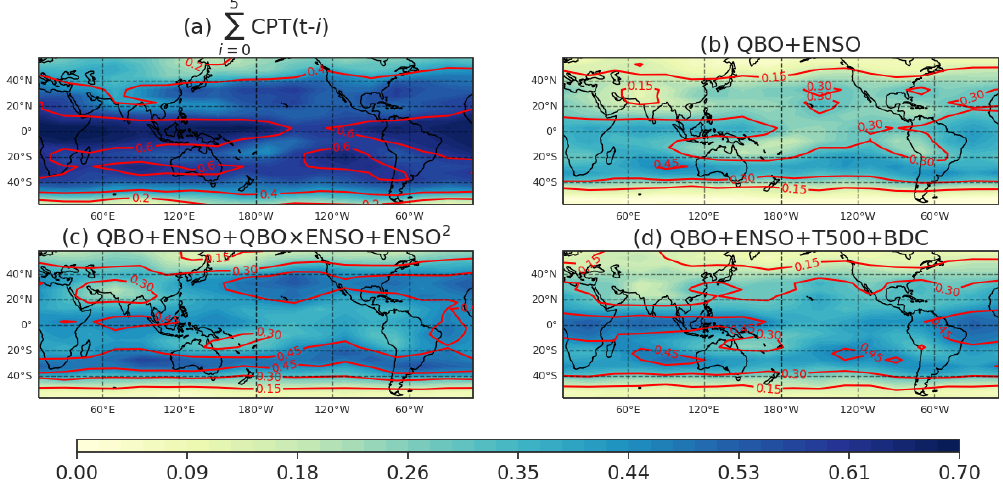
Figure 3. The R 2 of the MLR between water vapor anomalies at the 82.54hPa level with the four groups of predictors: (a) cold-point temperatures, (b) QBO and ENSO, (c) as in (b) but adding in ENSO 2 and QBO × ENSO, and (d) as in (b) but adding in T500hPa and the BDC. This MLR spans from 2005 to 2019 and uses the 3D SWOOSH product. The regression is reconstructed directly from all predictors, i.e.,